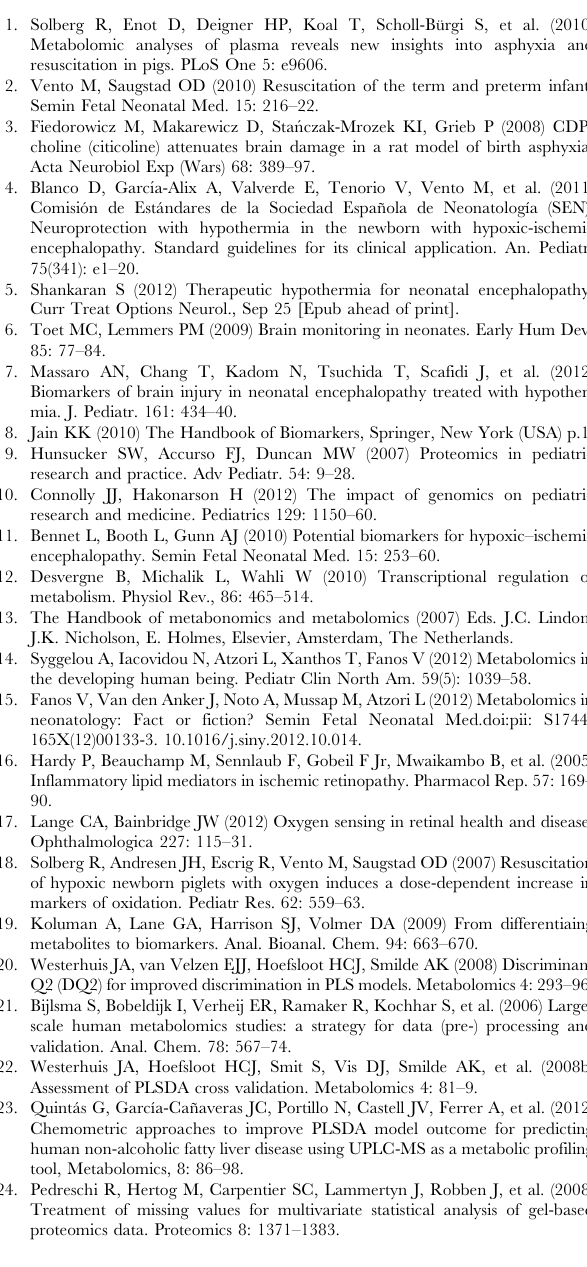
Figure S3 Selection of differentiating variables. Mean regression PLSDA vector obtained from leave one out 2CV and confidence boundaries calculated during the permutation test for the identification of discriminant metabolites (solid green circles). Figure S4 HILIC-UPLC-MS/MS typical chromatograms of choline, acetylcholine and CDP-choline. Chromato- grams of choline (A), acetylcholine (B) and CDP-choline (C) obtained from the injection of a standard solution (concentrations were 10 m M, 78 nM and 5 m M, respectively) and hypoxic and normoxic retina samples. Note: chromatographic conditions described in section Quantitative analysis of choline, acetylcholine and